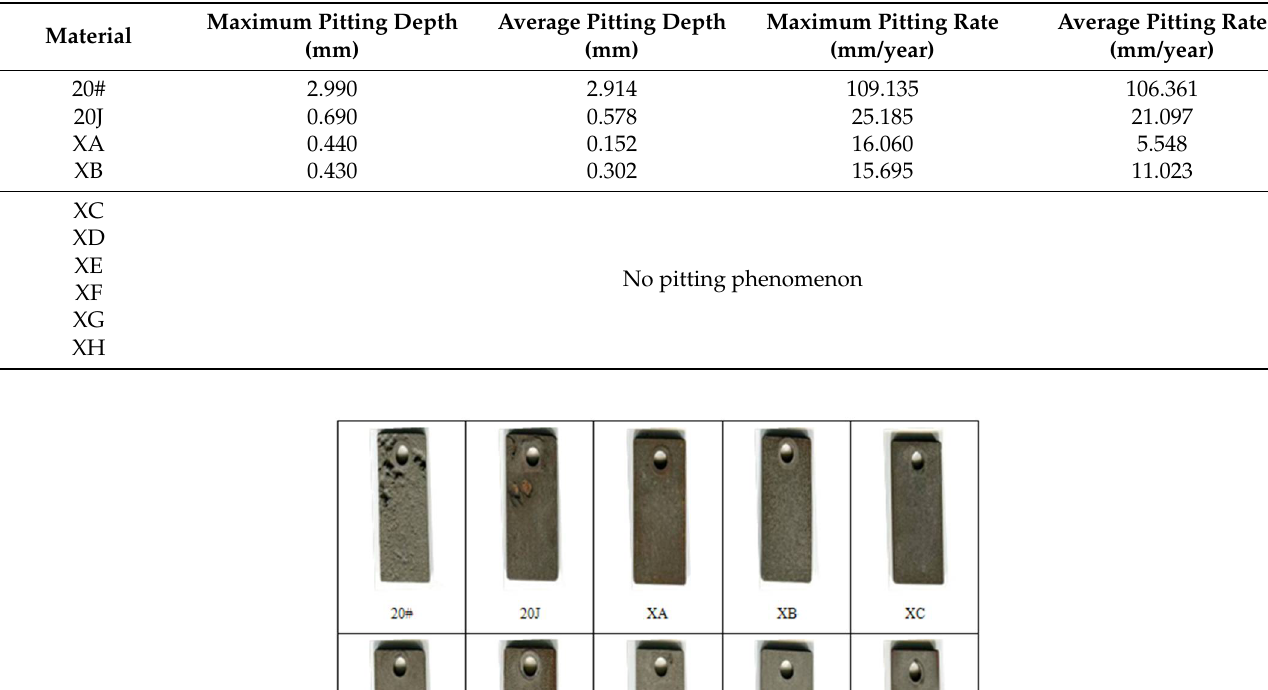
Table 14. Pitting rate in the case of CO 2 partial pressure of 1 MPa and 80 ◦ C.